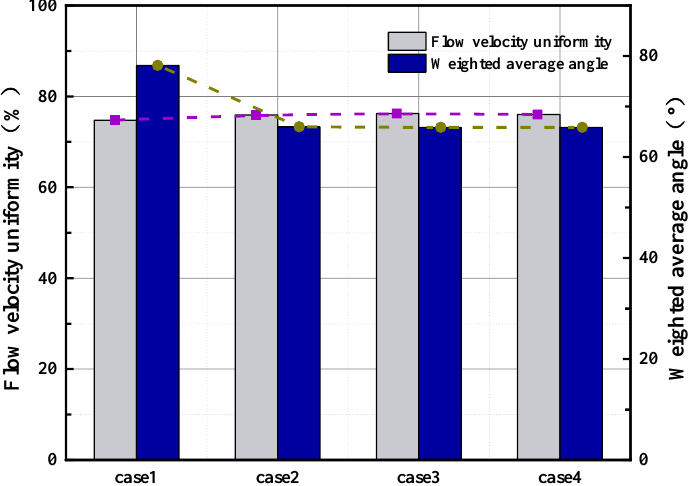
Figure 8. The uniformity of the velocity distribution and weighted velocity average swirl angle at the bell mouth inlet.